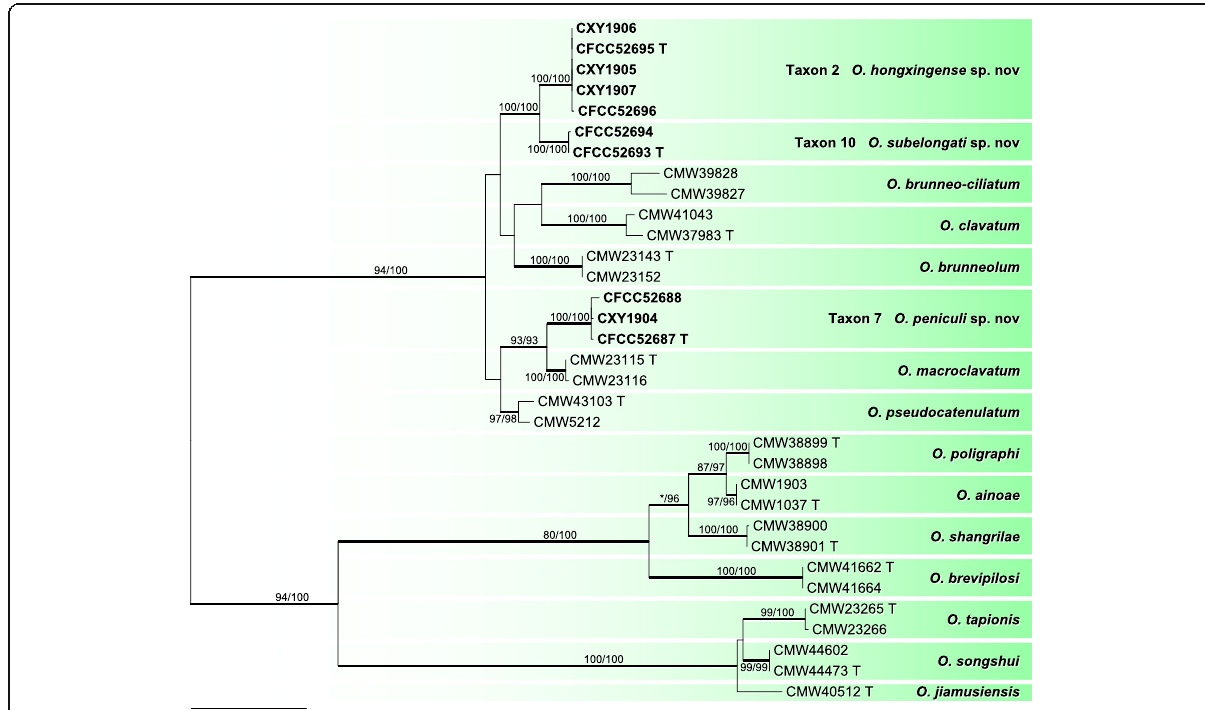
Fig. 6 ML tree of O. clavatum complex generated from the combined ( β T + CAL + EF-1 α ) sequence data. Sequences generated from this study are printed in bold. Bold branches indicate posterior probability values ≥ 0.9. Bootstrap values of ML/MP ≥ 70% are recorded at the nodes. T = ex-type